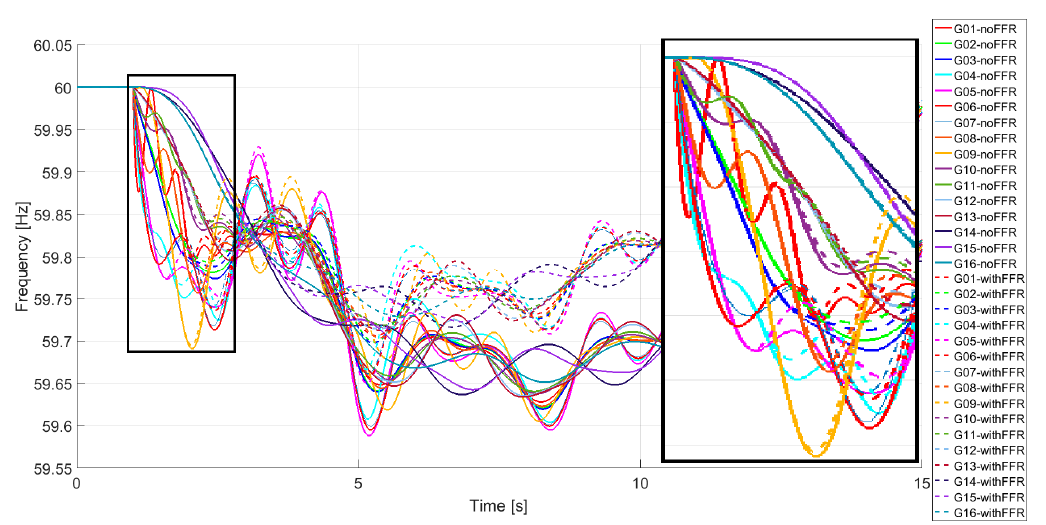
Figure 20. IEEE 68-bus system.